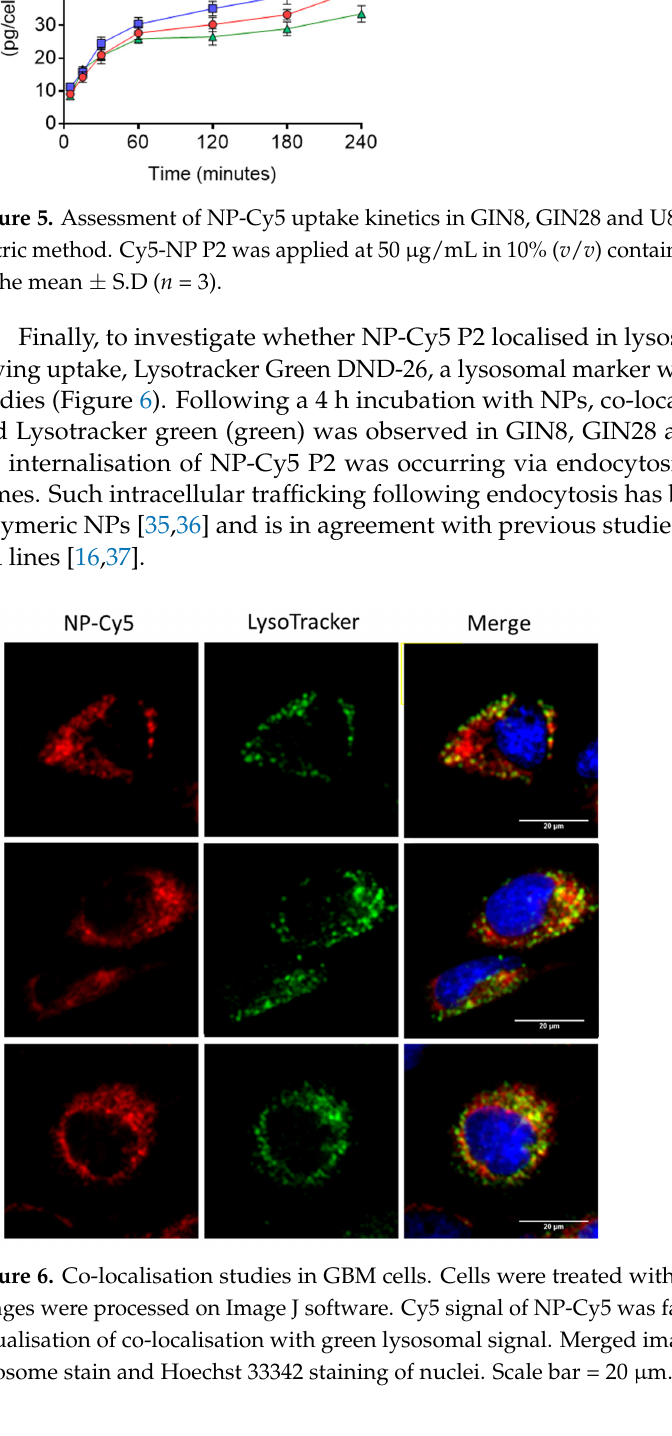
Figure 6. Co-localisation studies in GBM cells. Cells were treated with 50 µg/mL NP-Cy5 for 4 h. Images were processed on Image J software. Cy5 signal of NP-Cy5 was false coloured to red to aid in visualisation of co-localisation with green lysosomal signal. Merged images include NP-Cy5 signal, lysosome stain and Hoechst 33342 staining of nuclei. Scale bar = 20 µm. As apparent in Figure 7, a burst release of DOX from the NPs occurred over the first 6 h (Figure 7B(B I )), with over 60% of DOX released within the first 24 h. After this time point, steady state release was observed, with just over 80% of the drug cumulatively re- leased over the following 44 days (Figure 7B). This burst release was surprising, consid- ering the expected stability of the urea bond conjugating the DOX to the polymer back- bone [38]. However, it has been reported that a urea bond can be weakened when a large, sterically hindered substituent group constitutes the secondary amine [39,40], and in this